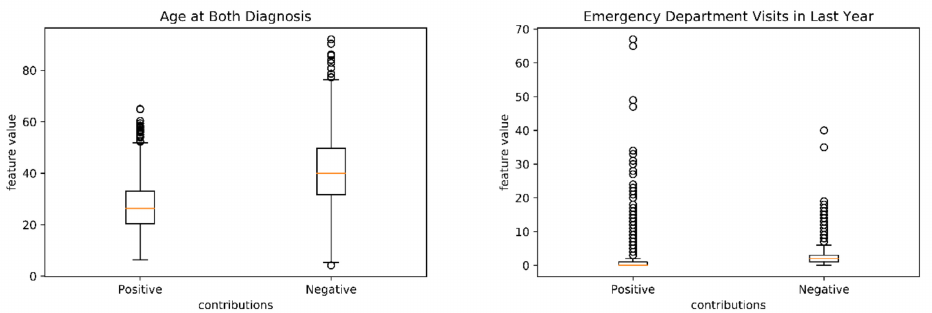
Figure 4. Distribution of age and ED visits in correctly predicted cases. Age distributions and ED visits are significantly di ff erent in two groups. Younger patients and patients with more ED visits are associated with higher-risk of